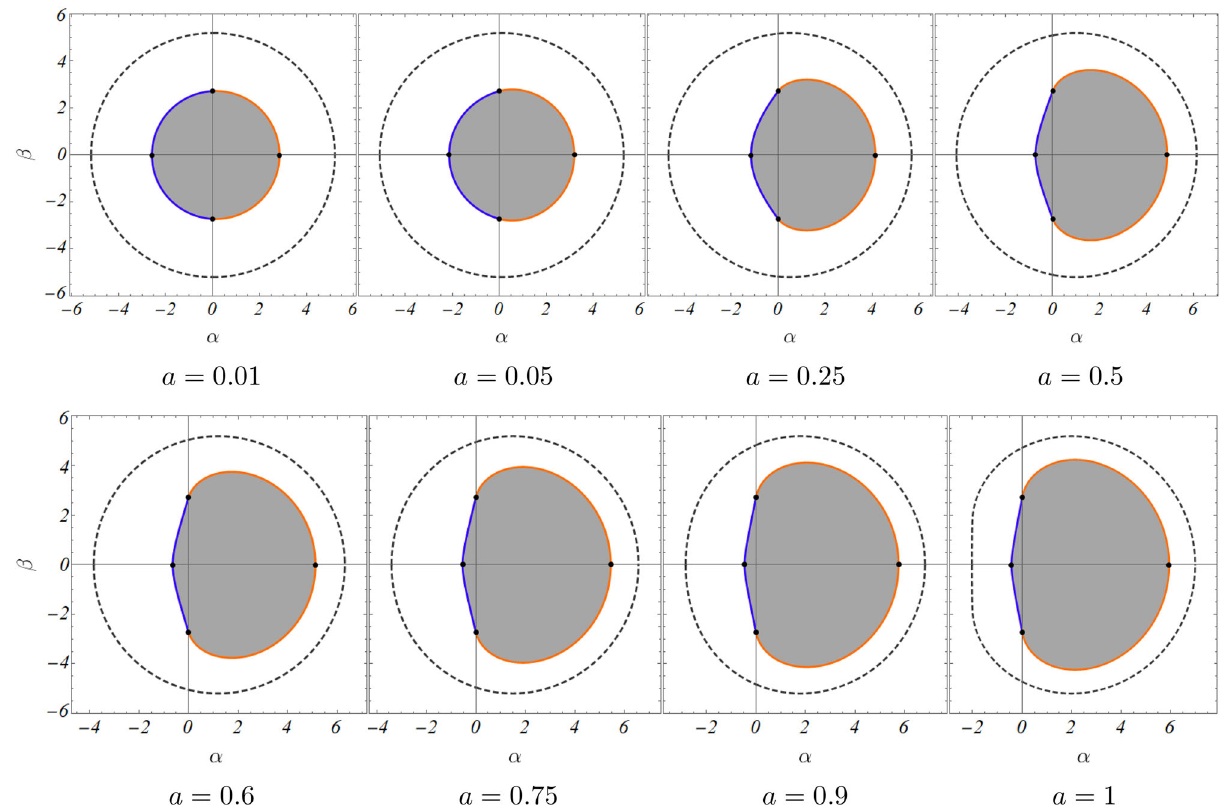
) , of the shadow, evaluated analytically according to Eqs. (11) and (12), r and the intersection points of the two branches. The shadow boundary oftheKerrblackholeispresentedforcomparisonwiththeblackdashed line. The mass of the solutions is set equal to 1